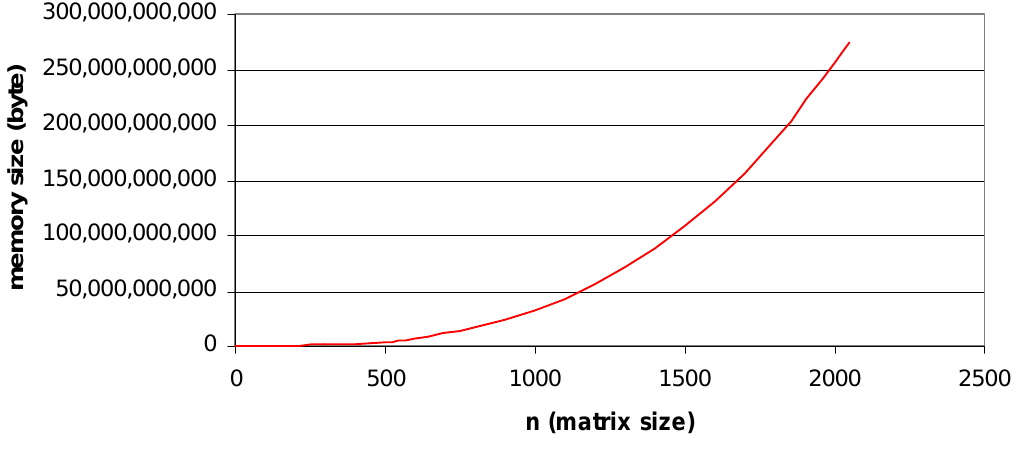
Figure 16. A graph of n versus memory